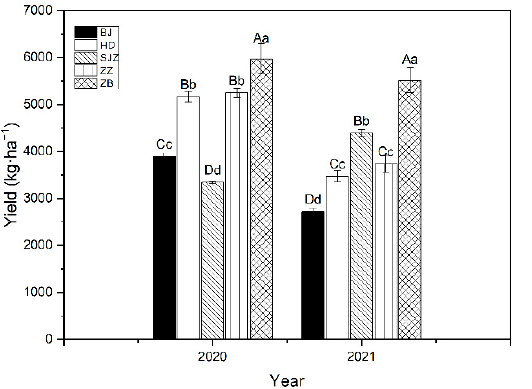
10 of 18 Figure 4. Polygon view of the AMMI biplot for 6 varieties evaluated across 5 study sites in 2020– 2021. ZZ, SJZ, BJ, ZB, and HD represent 5 study sites. JIN21, JI25, JI39, YG35, JM1, and ZG2 represent 6 varieties. The varieties farthest from each direction were connected to green straight lines, such as JI39, JM1, YG35, and JIN21, to form a quadrilateral and four vertical lines (green dotted lines) on the four sides through the center, dividing the diagram into four sectors and the environment into three sectors. Zhengzhou, Handan, and Shijiazhuang were in a group, while Zibo and Beijing were in the other group. The varieties located at the top corner of the quadrilateral were with the highest yields in each environment in the sector. For ex- ample, YG35 witnessed the highest yield in Beijing, while ZG2 showed the lowest yield.